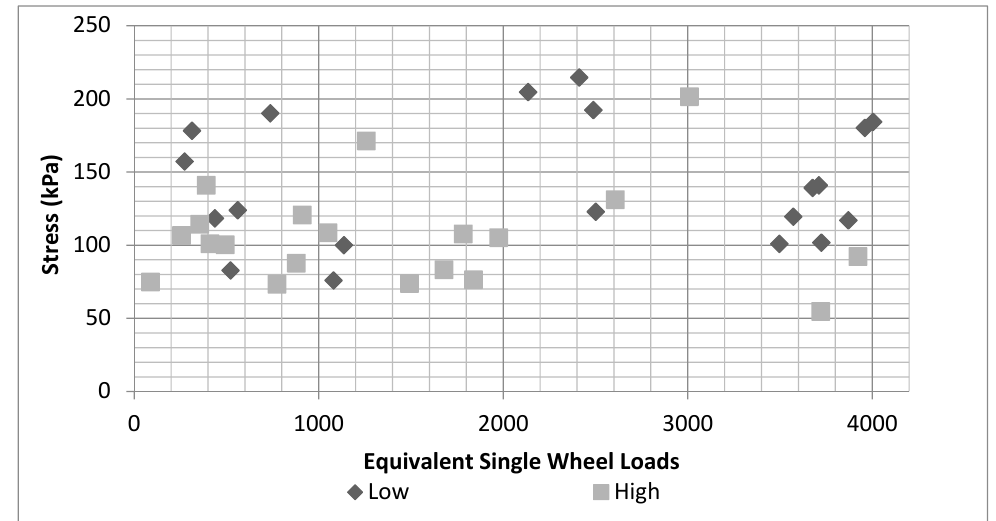
Figure 6. The 20 largest subgrade stress readings per plate. 240